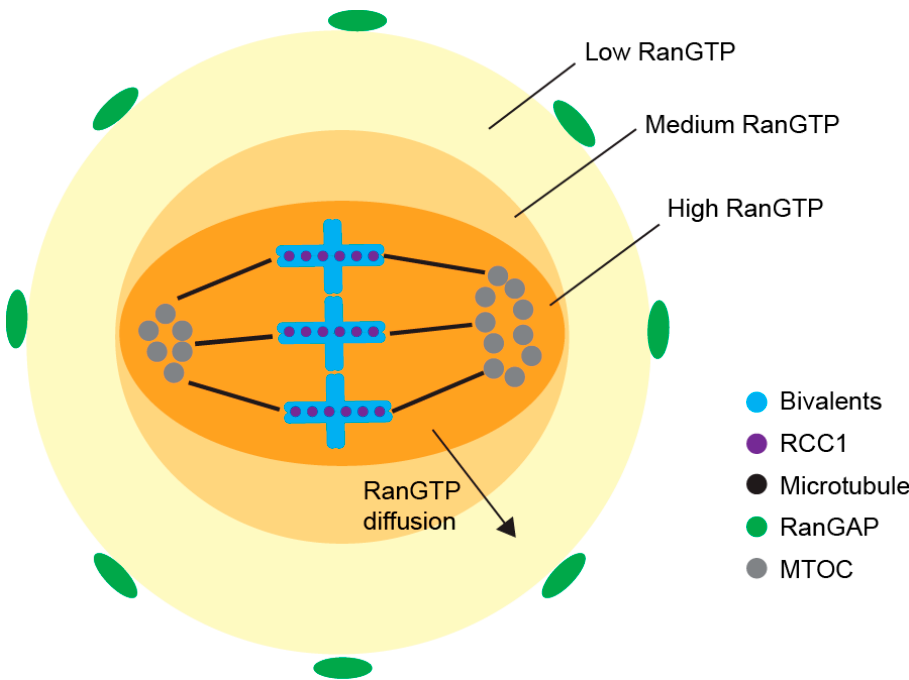
Figure 5. RanGTP gradient around meiosis I spindle—at the chromosomes, RCC1 converts RanGDP to RanGTP and diffusion of RanGTP forms the RanGTP gradient. In the cytoplasm, RanGAP converts RanGTP back to RanGDP, setting the boundary for the RanGTP gradient, and defining the region for spindle formation in the oocyte.